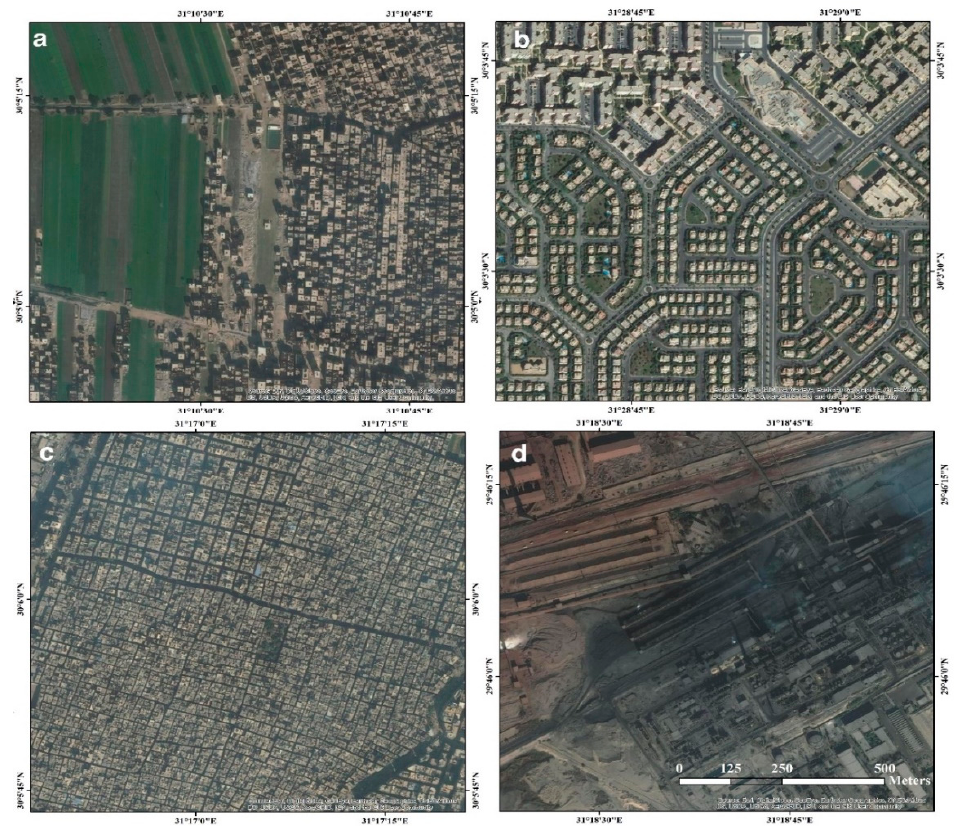
Figure 13. Spatial portraits of different LCLU types in Greater Cairo, reflecting the strong heterogeneous landscape of Greater Cairo. Each panel represents a pixel of 1 km, where ( a ) represents a suburban agricultural zone located to the west of Al-Waraq island in western Cairo; ( b ) represents a well-planned suburban residential zone, characterized by its low-height building, in the east of the city; ( c ) represents a classic heavily urbanized and populated area in central Cairo (Al Waely district); and ( d ) represents the industrial complex of Helwan in southern Cairo.